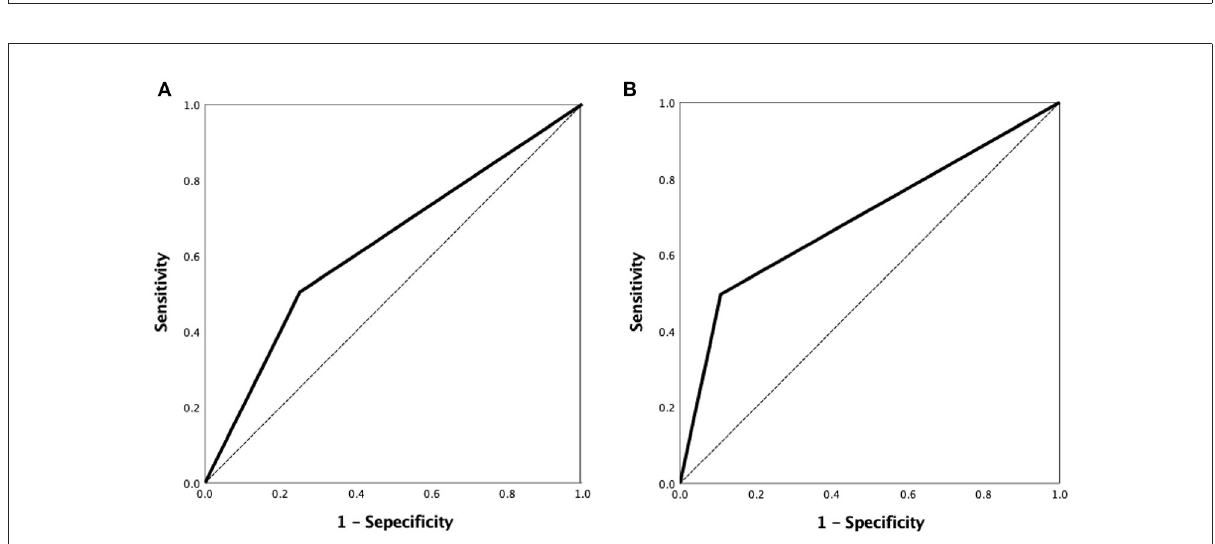
FIGURE4 ROC curve analysis of the VBAC to predict ICAS-O was performed with the area under curve (AUC) of 0.626 (95% confidence interval [CI] 0.570–0.680, p < 0.001) (A) and 0.695 (95%CI 0.627–0.757) in the non-AF group (B) . ROC, receiver-operating characteristic.